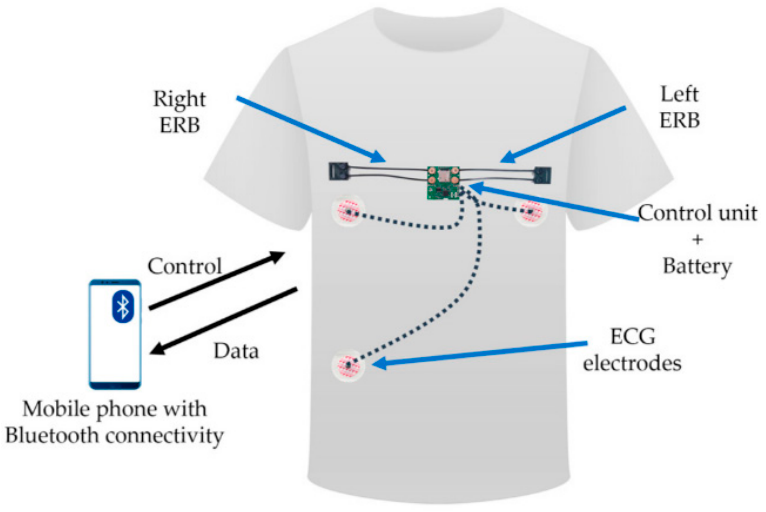
Figure 11. Structure of the VitalCore wearable device with highlighted the main components [117].